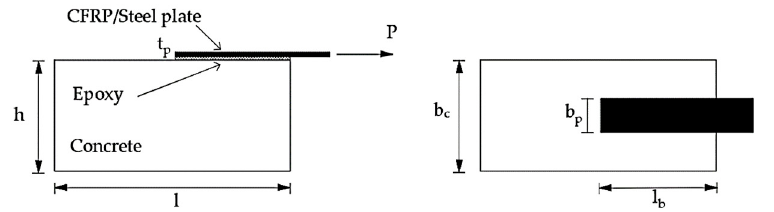
Figure 1. Scheme of single shear bond test.